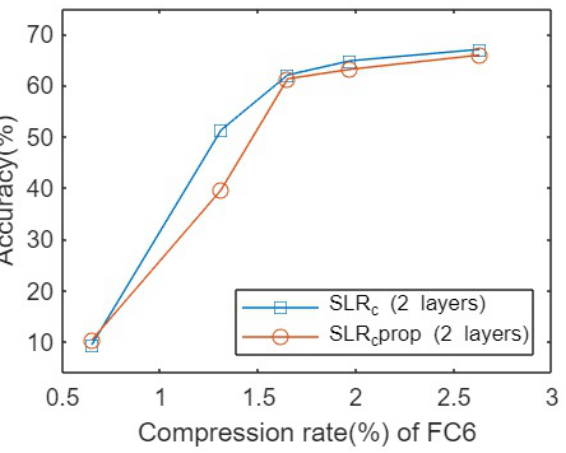
Figure 3. Accuracies for pruning VGG16 network on Cifar100 dataset for different compression